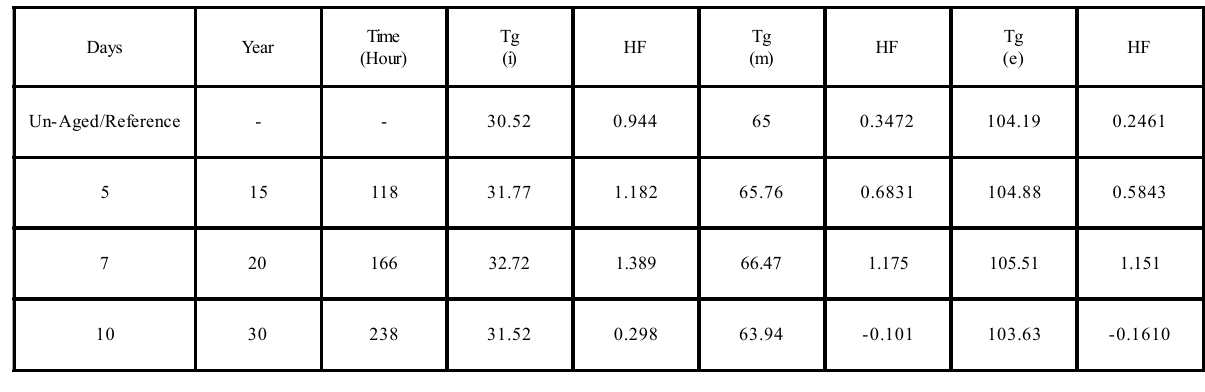
TABLE 6. DSC TEST RESULTS FOR SPECIFIED